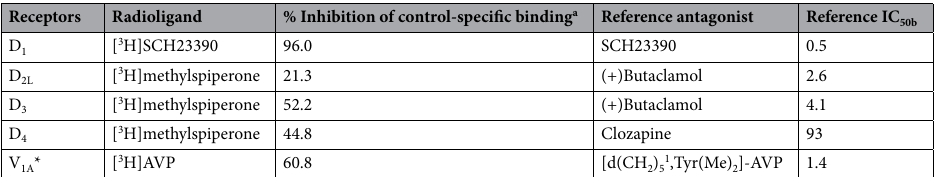
Table 3. Human dopamine D 1 , D 2 , D 3 , and D 4 and vasopressin V 1A receptor binding data of isoliquiritigenin. *Agonist binding. a Values are presented as the mean of the percent inhibition of control specific binding by 100 µM isoliquiritigenin performed in duplicate. b The IC 50 value of the reference antagonist (nM).